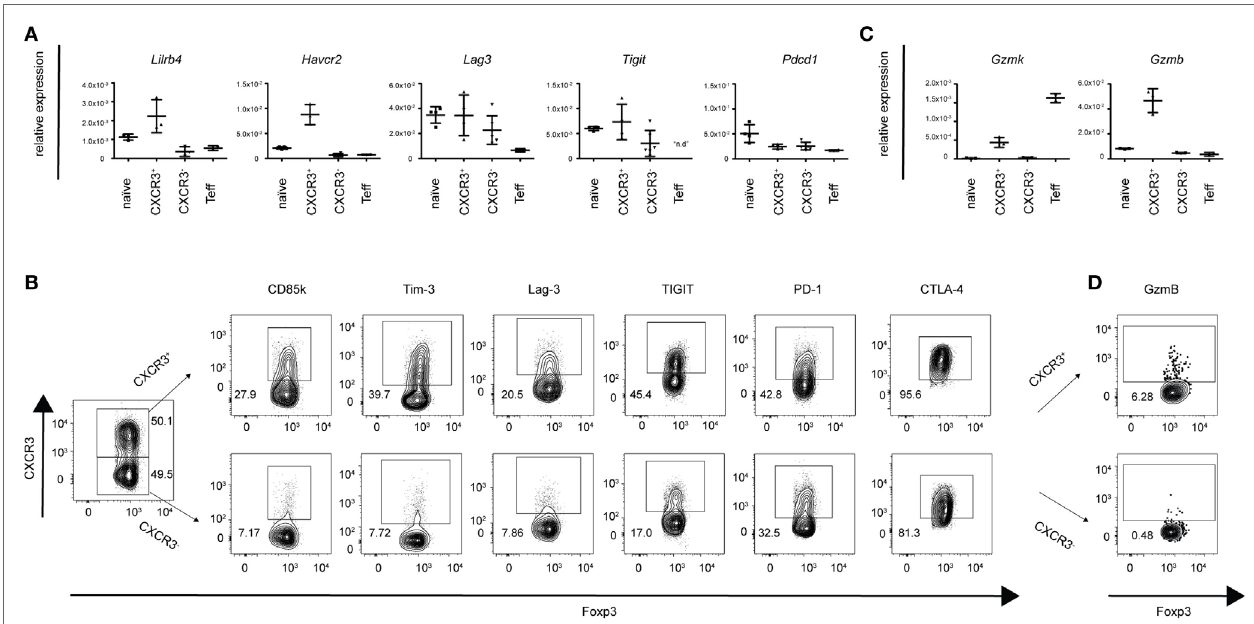
FigUre 3 | CXCR3 + Treg cells express a specific set of co-inhibitory receptors and cytotoxic molecules. Differential expression of a selection of genes coding for co-inhibitory receptors and granzymes was determined in pooled spleens and LNs from naïve or day 14 LCMV-infected mice. (a,c) Transcriptional expression levels were quantified by qPCR in sorted CXCR3 + , CXCR3 − , naïve Treg cells, and CD4 + Foxp3-GFP − effector T cells and (B,D) protein levels in CXCR3 + and CXCR3 − Treg cells were determined by flow cytometry (n.d., not